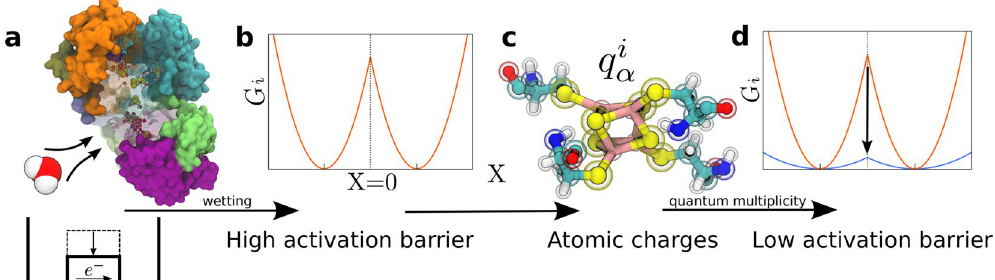
Figure 2. Conceptual framework. ( a ) Wetting of the protein internal pockets lowers the tunneling barrier for electron transfer 21, 22, 24 (see discussion in the text). ( b ) The activation barrier calculated from MD simulations by using the Marcus theory (equation 1) is too high to be consistent with the experimental transport time of  200 μ s. ( c ) Nonergodic electron transfer is introduced within the classical scheme of partial atomic charges interacting with the electrostatic potential created by the protein and water. This formalism requires two reorganization energies, λ St and λ , in equation (6). ( d ) The QM/MD formalism allows multiplicity of quantum states and deformation (polarizability) of the electronic distribution of the cofactor in response to electrostatic fluctuations. The vertical arrow indicates the lowering of the activation barrier due to κ  1 in equations 5 and G